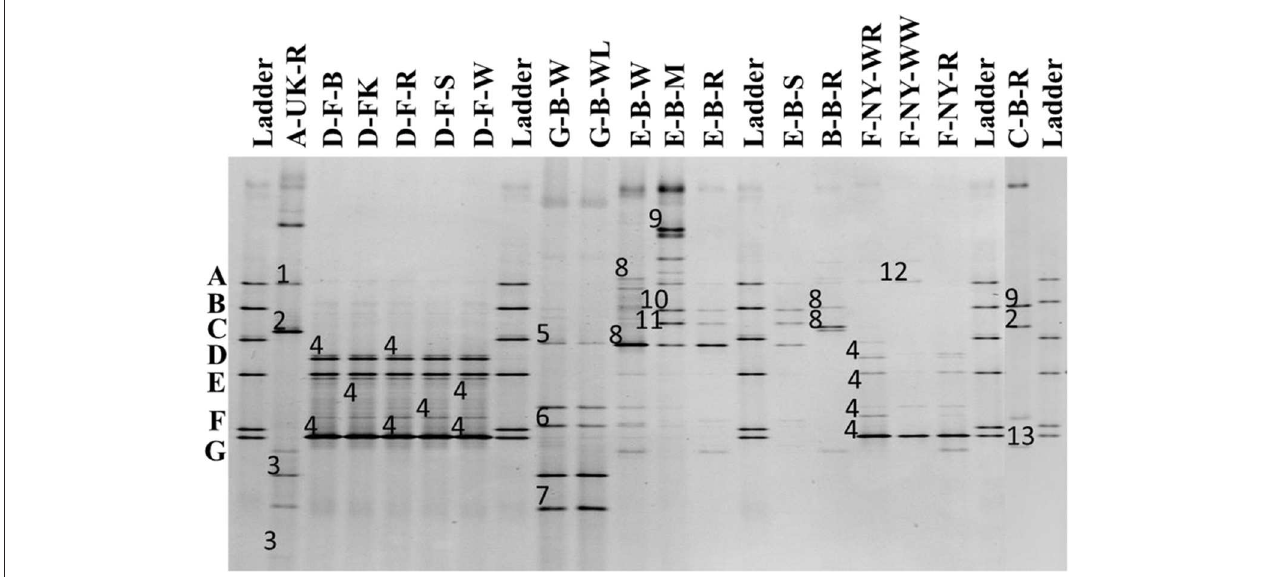
FIGURE 3 | Culture-independent 16S rRNA-PCR-DGGE community profiles of 17 sourdough samples from backslopped sourdoughs of different origins. The sample codes on top of each row are as described in Table 1 . The ladder was constructed using pure cultures of Lactiplantibacillus plantarum IMDO 130201 (A) , Limosilactobacillus fermentum IMDO 130101 (B) , Latilactobacillus sakei IMDO CG1 (C) , Lactobacillus amylovorus DCE 471 (D) , Companilactobacillus crustorum LMG 23699 (E) , Levilactobacillus namurensis LMG 23584 (F) , and Fructilactobacillus sanfranciscensis IMDO 150101 (G) . The following species were identified: 1, Lacp. plantarum (100% identity; accession no. KT025937.1); 2, Levilactobacillus brevis (99% identity; accession no. LC062897.1); 3, Lacticaseibacillus rhamnosus/paracasei subsp. paracasei/casei (100% identity; accession nos. LC145553.1/LC096209.1/LC064894.1); 4, Fl. sanfranciscensis (100%